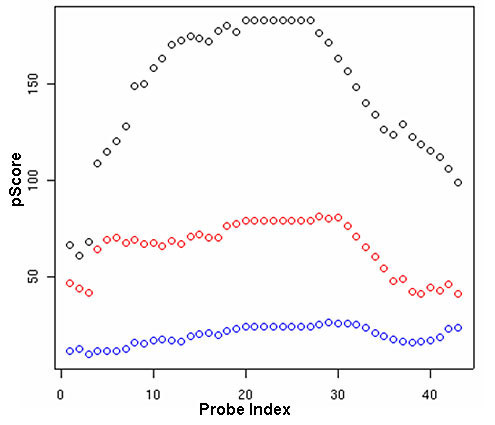
Biases in the parametric binary segmentation method for detection of putative enrichment sites-I. pScore distribution across 43 consecutive probes in three different biological (B1-B3) replicates, are shown. Probes belonging to B1 (black) and B2 (red) pass the pScore threshold of 50 while those belonging to B3 (blue) fail by a significant margin. The trend in the pScore distribution hints at potential enrichment but if B3 were the only dataset available a false negative bias could have been introduced in the analysis.